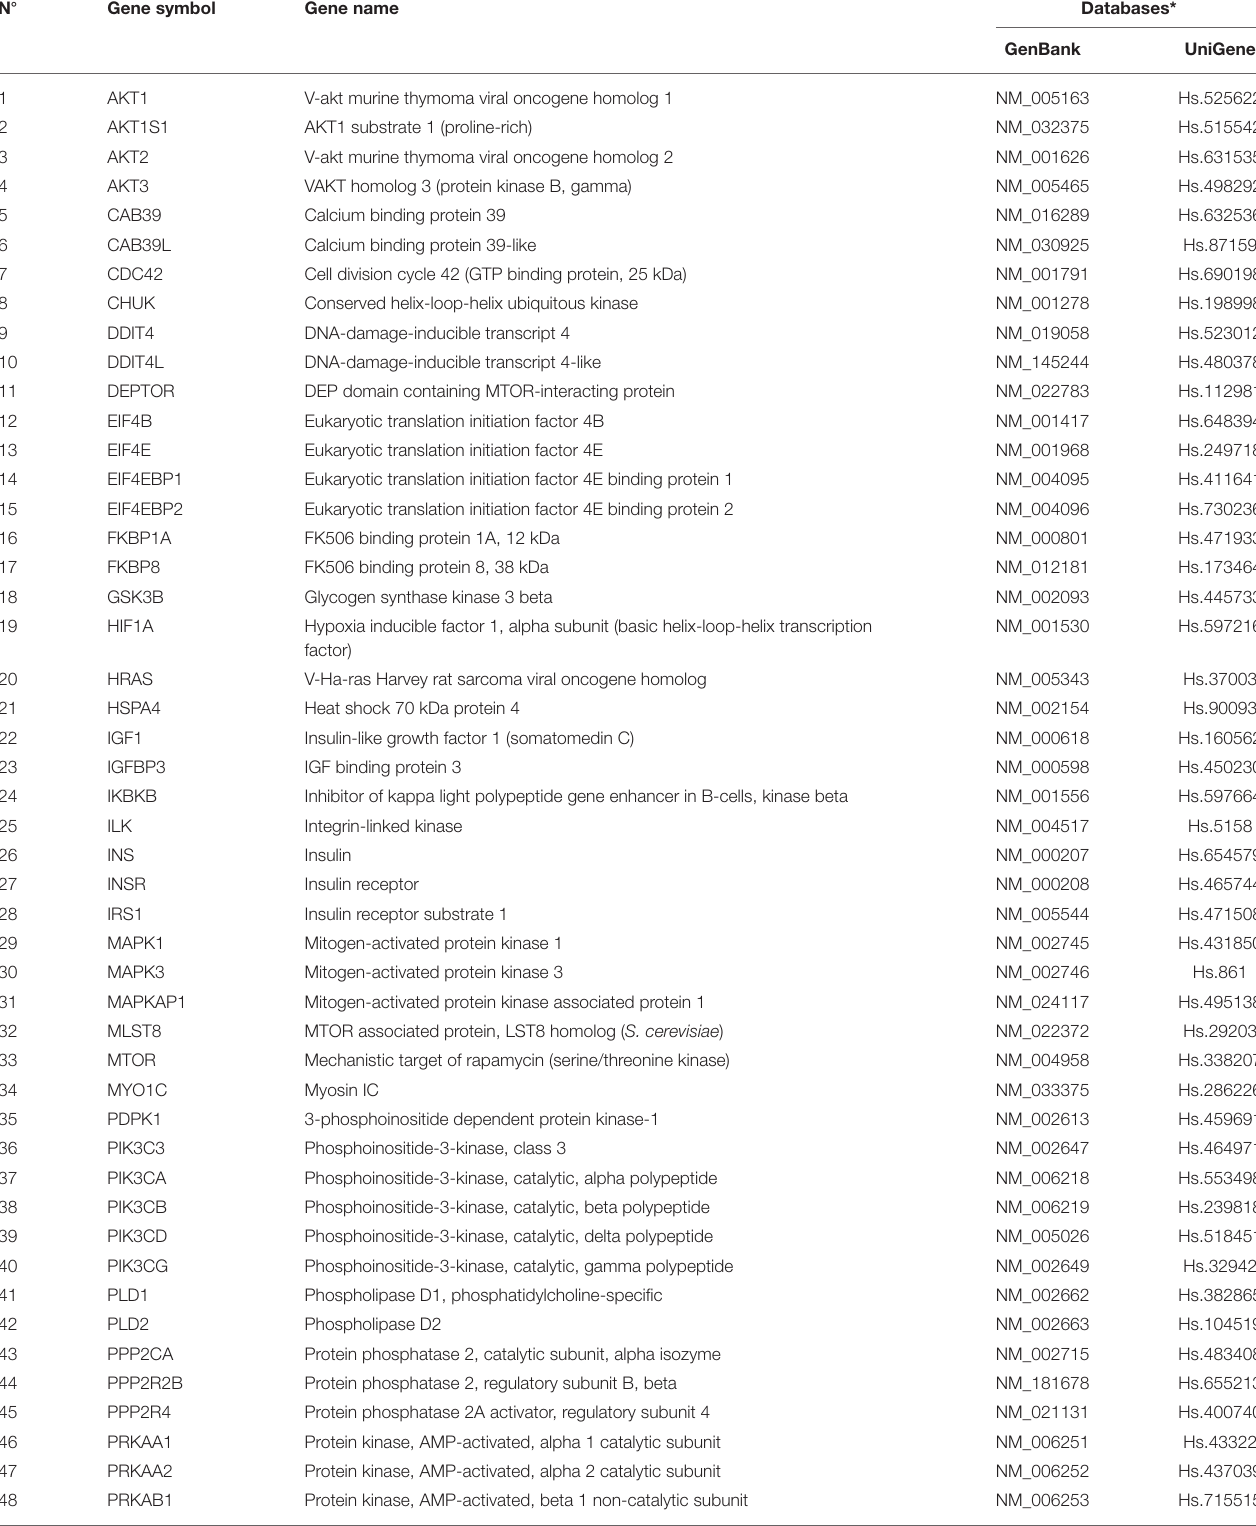
TABLE 2 | Summary of 84 human mTOR pathway related genes analyzed by qPCR array in the kidney biopsies. N ◦ Gene